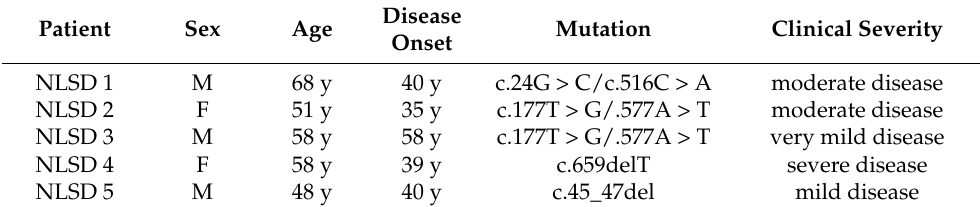
Table 1. Clinical and genetic characteristics of NLSD